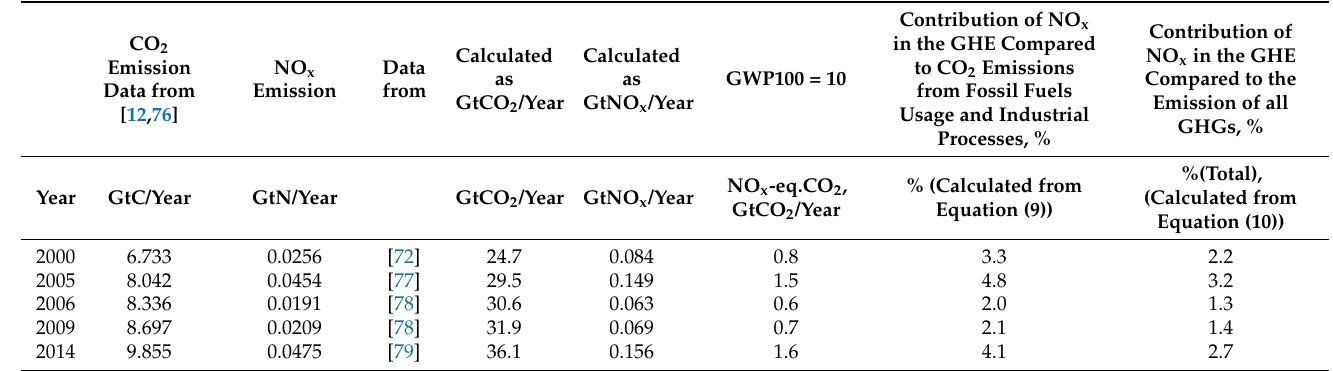
Table 3. Estimation of the participation of NO x emitted from surface sources in the GHE compared to CO 2 and other direct GHGs. Pessimistic scenario (GWP 100 =